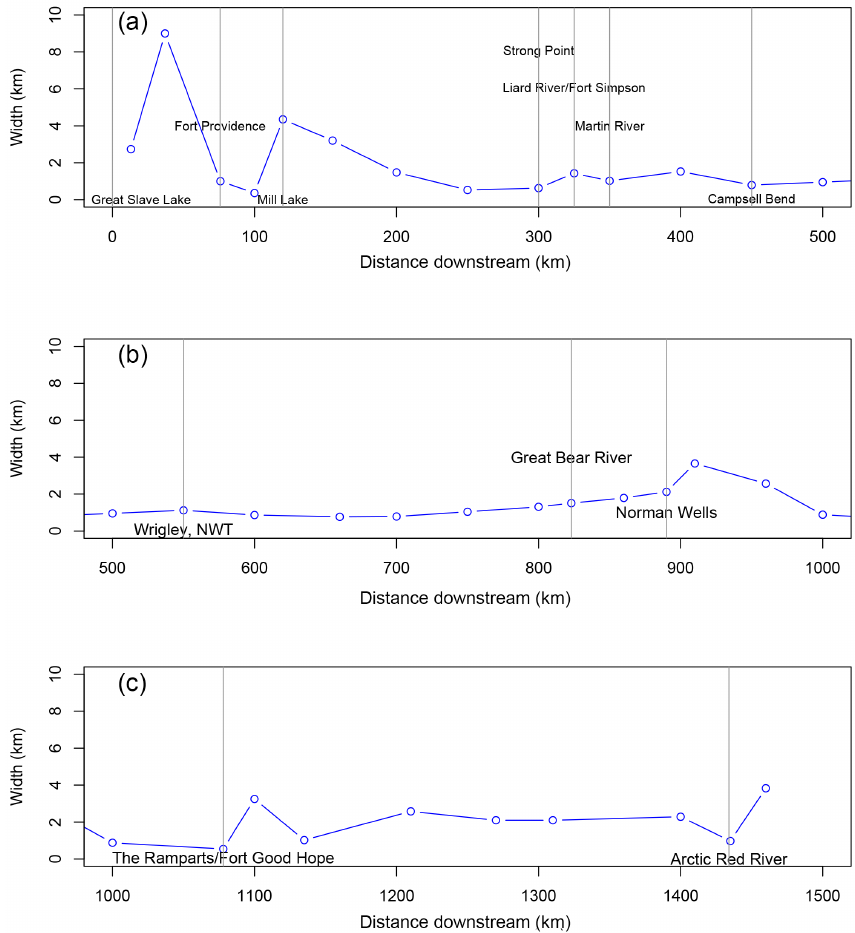
Figure 7. Change in channel width along the Mackenzie River as observed in (a) (ca. 0–500km), (b) (ca. 500–1000km) and (c) (ca. 1000–